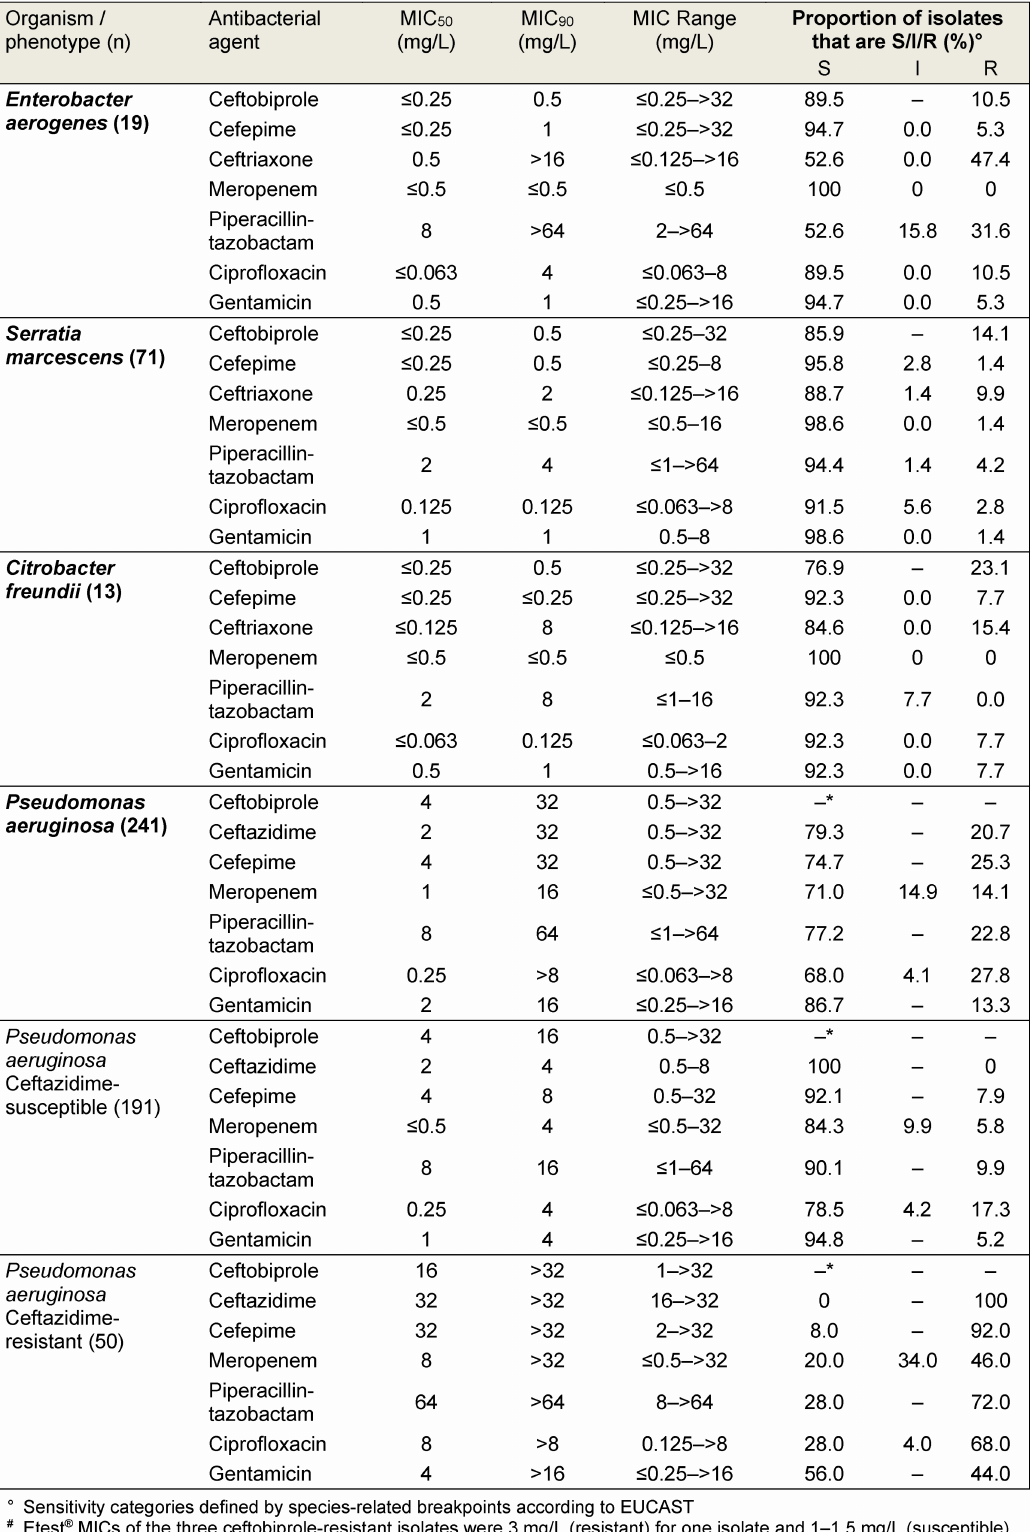
Table 3: In vitro activity of ceftobiprole and comparators against clinical isolates of most frequent bacterial species